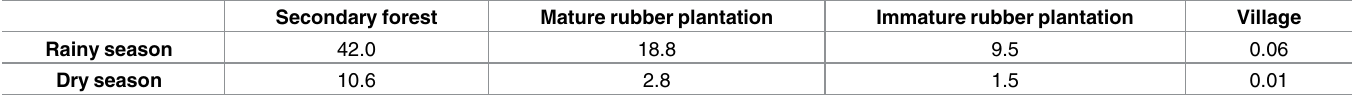
Table 4. The basic reproductive number (R 0 ) for dengue vector Ae . albopictus in the secondary forest, mature rubber plantation, immature rubber plantation, and village habitats during the rainy season and dry